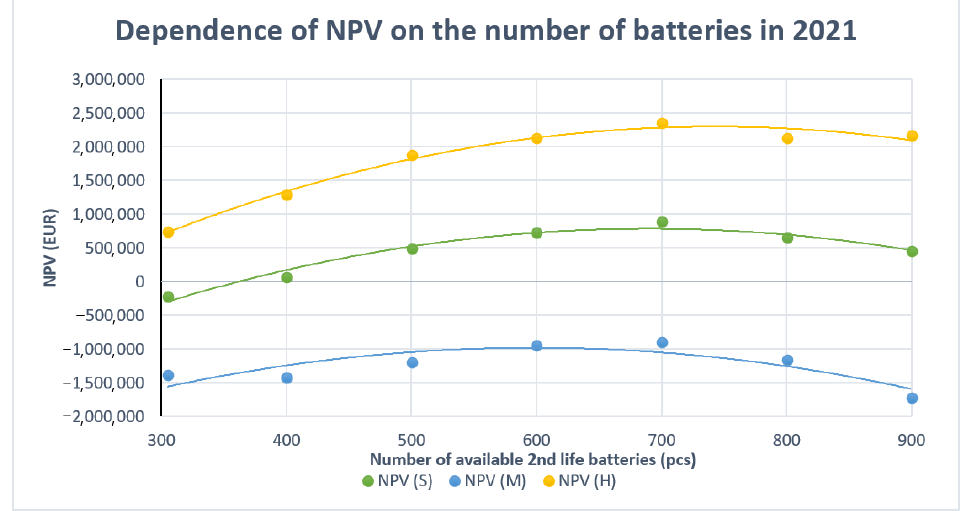
Figure 7. Dependence of NPV on the number of batteries of the large battery storage strategy.